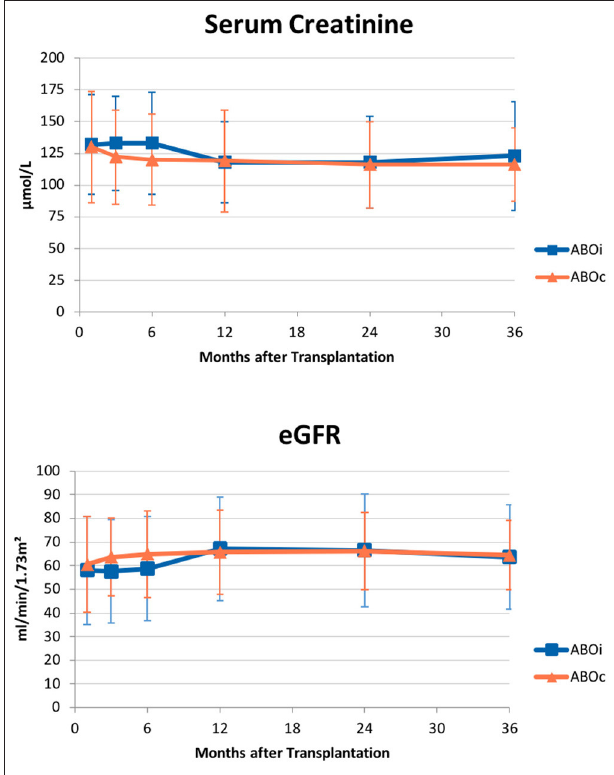
FIGURE 2 | Graft function over time. Mean ( ± SD) serum creatinine (upper panel) and estimated glomerular filtration rate (eGFR; lower panel) did not differ in AB0 incompatible patients and compatible controls at all considered intervals – 1, 3, 6 months, 1, 2, 3 years from transplantation.